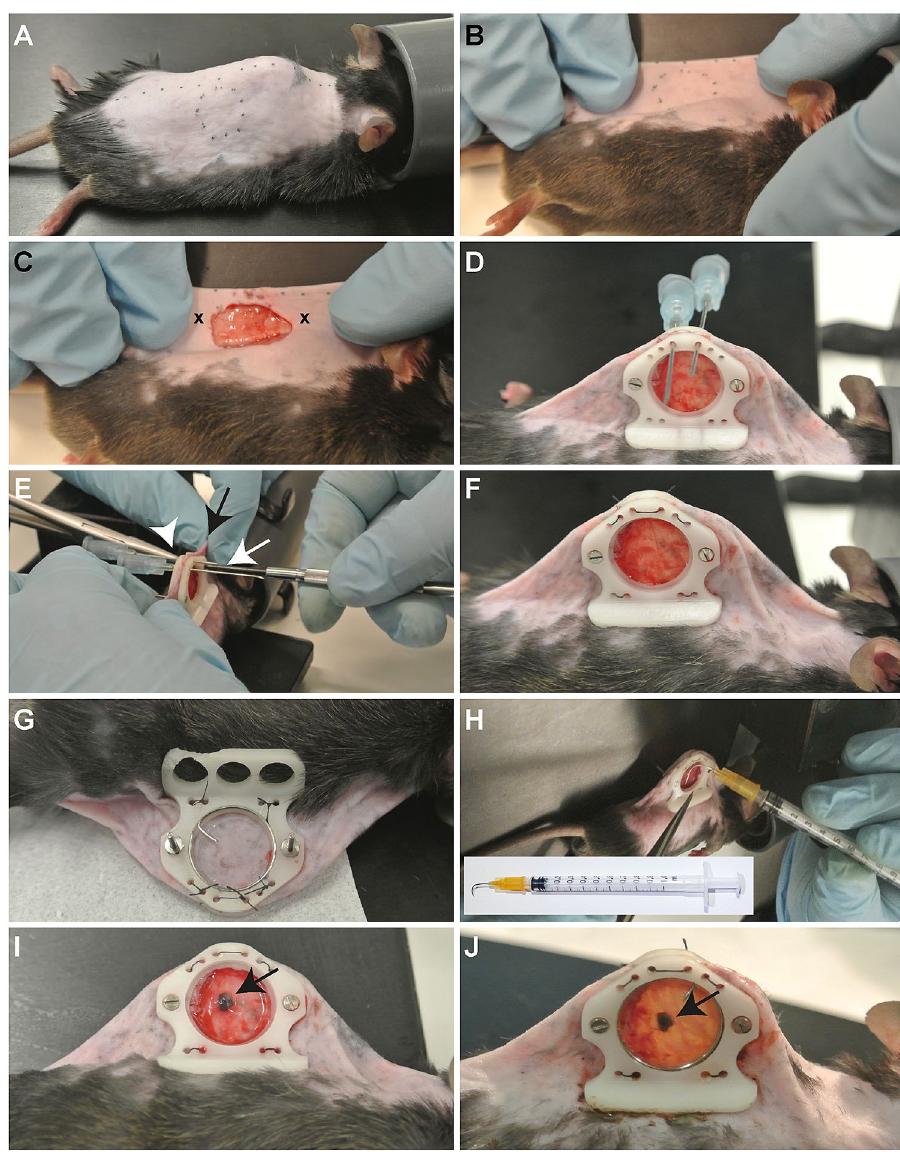
Figure 3. Surgical procedure. ( A ) The marked center line and window view area on the animal. ( B ) The skin folded using the central line as a folding point. ( C ) The exposed fascia after removal of skin and muscle layer inside the window view area. The cross (x) marks the spot to create the holes through the skin. ( D ) Front view of both window frames with screws and nuts (not yet tightened) and held in place with two 23G needles. ( E ) Tightening of the screws using a micro screwdriver (white arrow) and a needle holder (arrow head) to immobilize the nuts and holding of the skin (black arrow). ( F ) Replacement of the needles used to tighten the window frame with non-absorbable sutures and a knot on the backside and repeated for the other four pair of suture holes. ( G ) Back view of a 10 mm filler glass placed on the skin and closed with a 12 mm cover glass and secured with a retainer ring. ( H ) Creation of a pocket in the fascia using a 90° bent 25G needle for placement of the tumor piece. ( I ) The tumor piece (arrow) inserted in the pocket. ( J ) The end result after closing the chamber with a 12 mm blank coverslip or 12 mm gridded coverslip and secured with a retaining